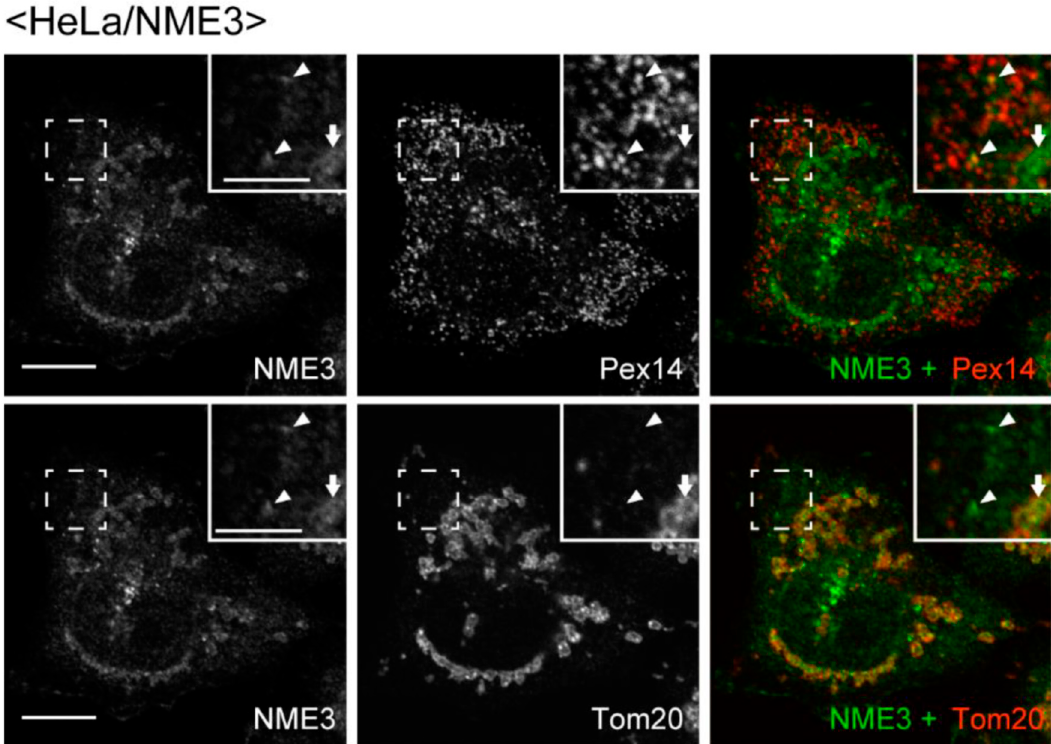
Figure 6. Intracellular localization of non-tagged NME3 in HeLa cells. Non-tagged NME3 was expressed in HeLa cells and stained with the antibody raised to DYNAMO1 (green). Peroxisomes and mitochondria were visualized with guinea pig anti-Pex14 (upper panels) and mouse anti-Tom20 (lower panels) antibodies, respectively. Peroxisomes are shown by a pseudo-color image. Scale bar, 10 µm. Higher magnification images of the boxed regions were shown (Inset). Scale bar, 5 µm. Arrowheads and arrows indicate peroxisomal and mitochondrial localization of NME3, respectively.